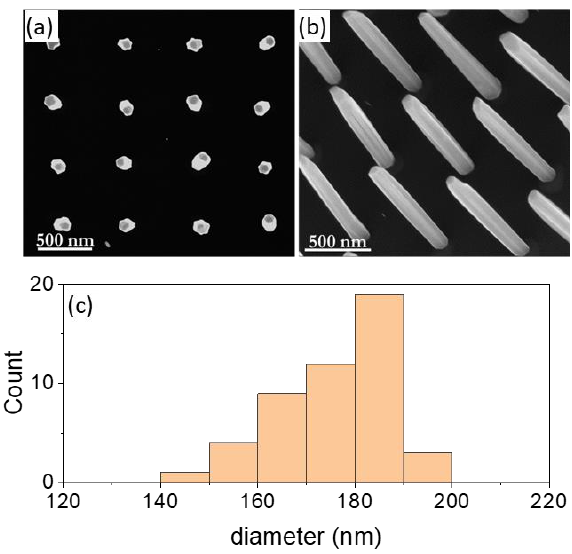
Figure 4. ( a ) Top- and ( b ) bird’s-eye view SEM micrographs; and ( c ) diameter distributions of the NRs grown at P N₂ = 90% for 90 min .